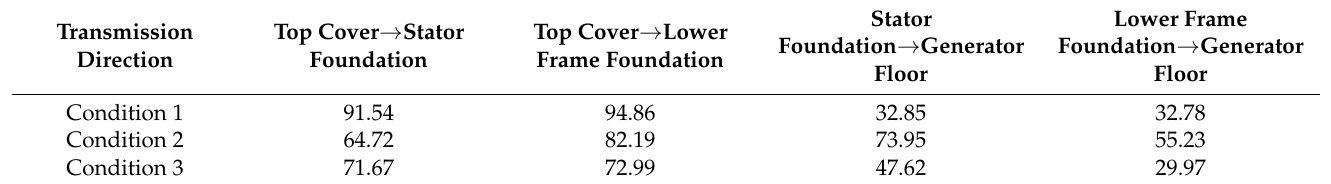
Table 7. Information-transmission rate between the main measurement points under three